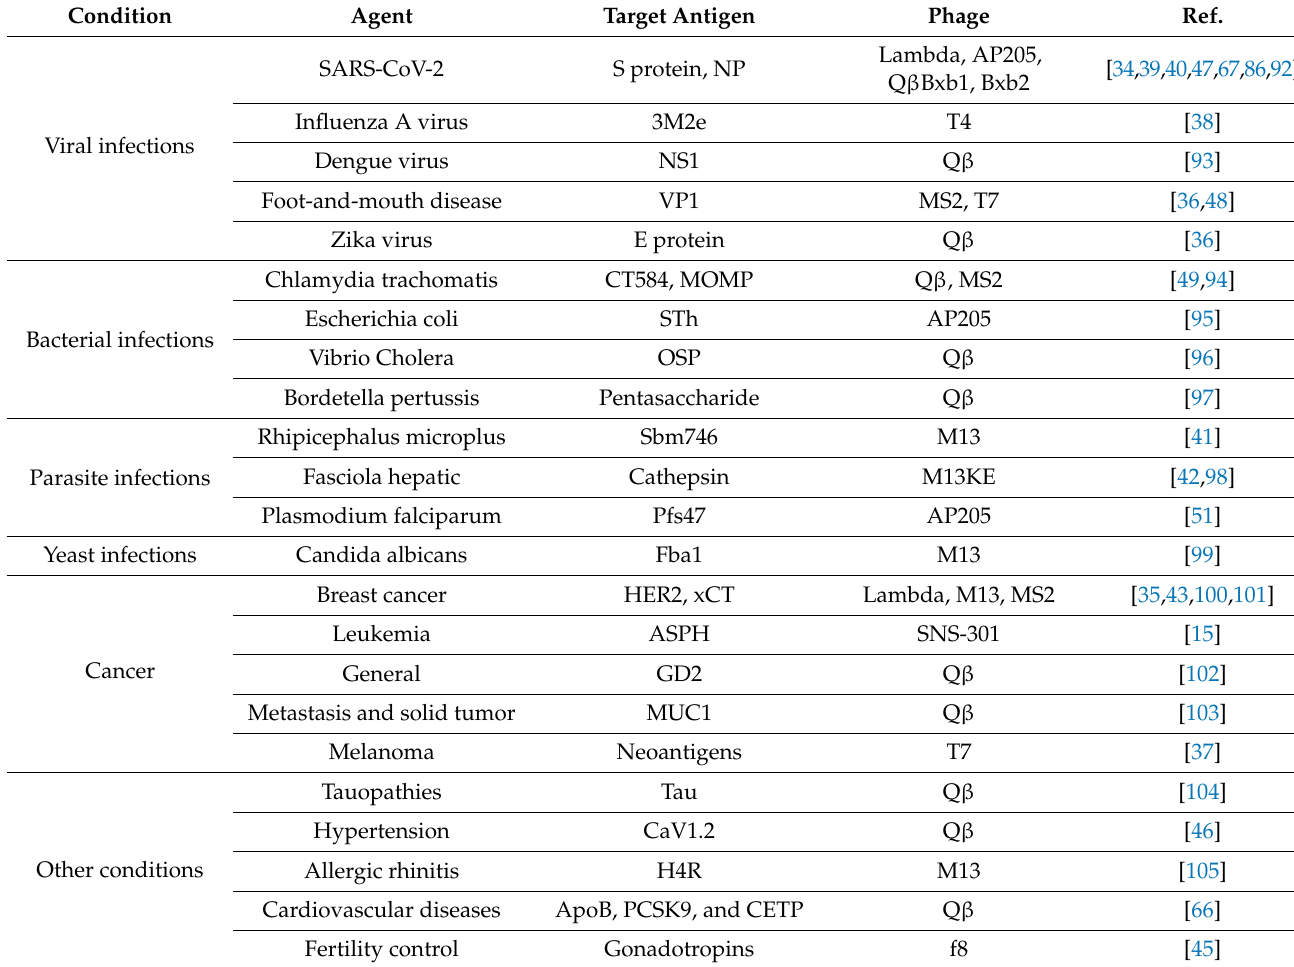
Table 2. Applications of phage-based